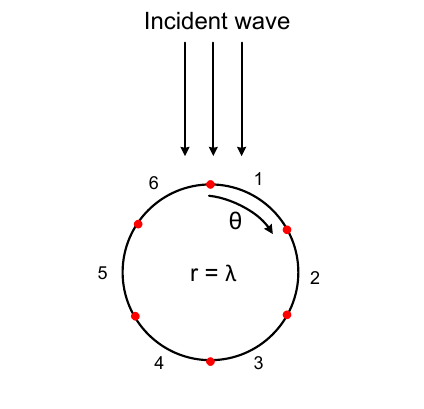
Figure 7: Scattering problem